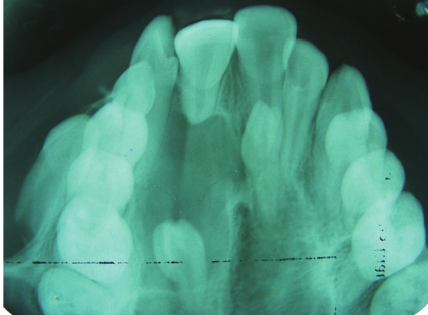
Figure 4: Maxillary occlusal radiograph showing two impacted supernumerary teeth. One on the right side is associated with a radiolucency having sclerotic border suggestive of dentigerous cyst.